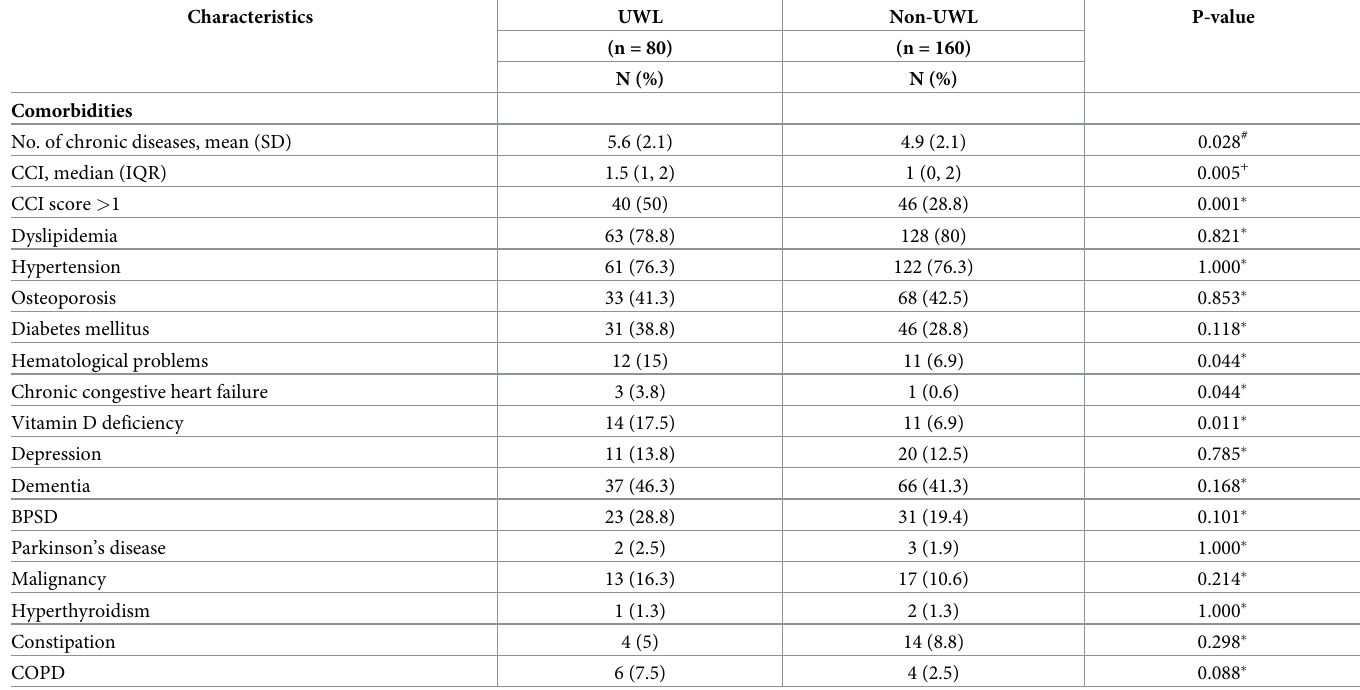
Table 2. Clinical characteristics among older patients in the geriatric outpatient clinic.